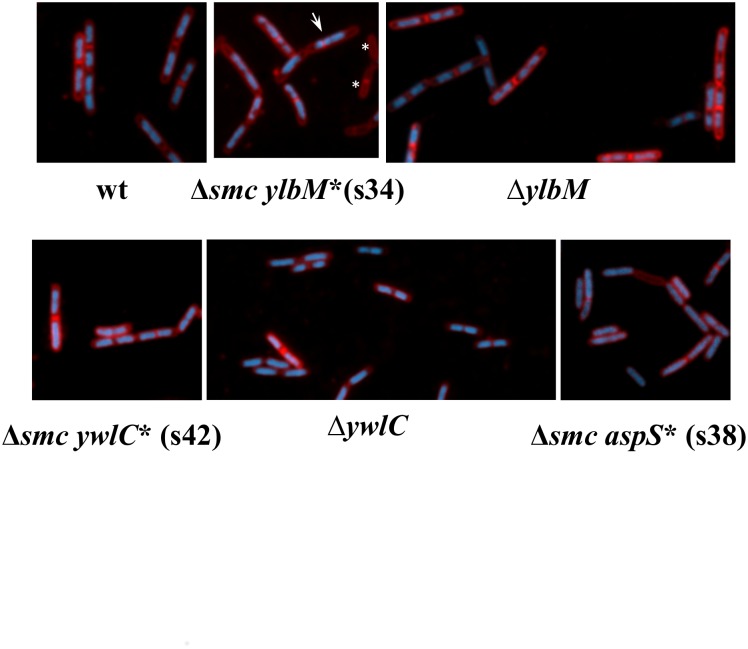
Microscopic observation of suppressors.Cells were grown in LB at 37°C to exponential growth phase (OD600nm between 0.3 and 0.6) and stained with FM4-64FX and DAPI to visualize membranes (red) and DNA (blue) respectively. The white arrow indicates a cell in which division septum was formed on none segregated chromosomes (guillotine phenotype); and anucleate cells are marked with asterisks.